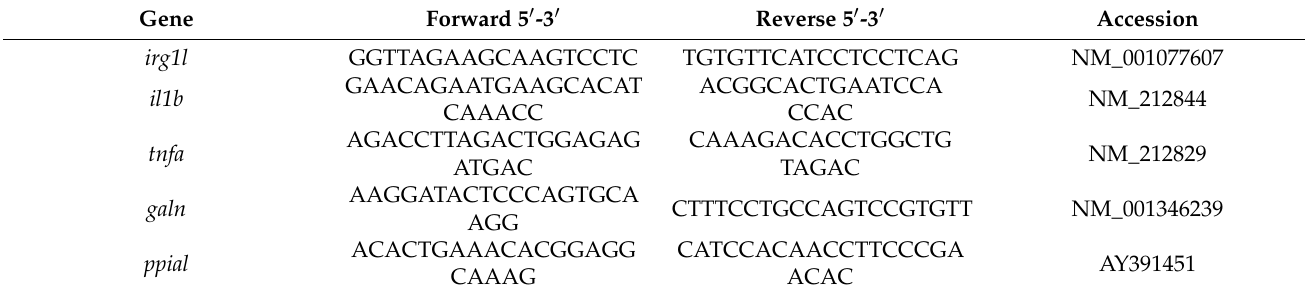
Table 1. Primer sequences and GenBank accessions for genes analyzed in this